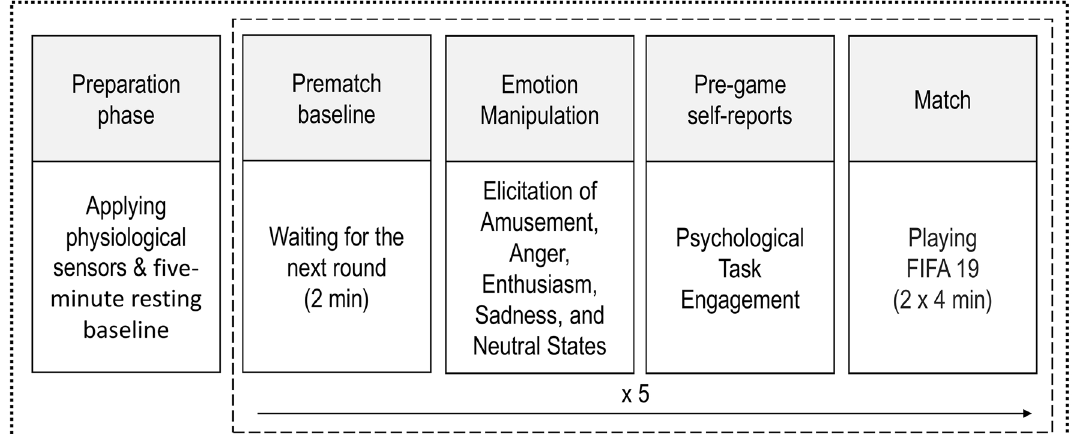
Figure 1. Study procedure. The dotted frame represents the study procedure. The dashed frame represents the repeated procedure of each of five rounds. The impact of 2-min emotion elicitation on the performance was not relevant to the present study aims and is reported in another article 36